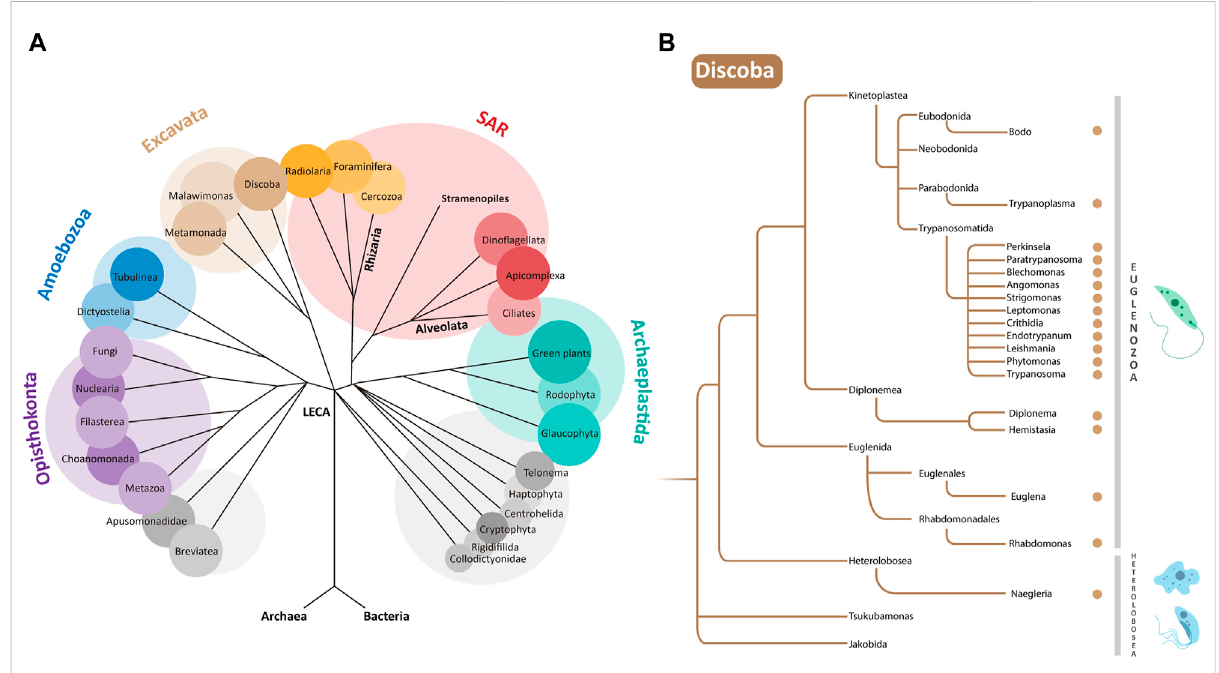
FIGURE 1 (A) Phylogenetic relationships of eukaryotes. LECA is the “ Last Eukaryotic Common Ancestor ” from which different supergroups evolved. Euglenozoa are a phylum within the supergroup Discoba belonging to the Excavata (Adl et al., 2019). (B) Zoom of a simpli fi ed representation of the Discoba clade. Genera containing organisms discussed in this paper are indicated by brown dots. Examples of organisms from the Euglenozoa and Heterolobosea phyla are depicted at the